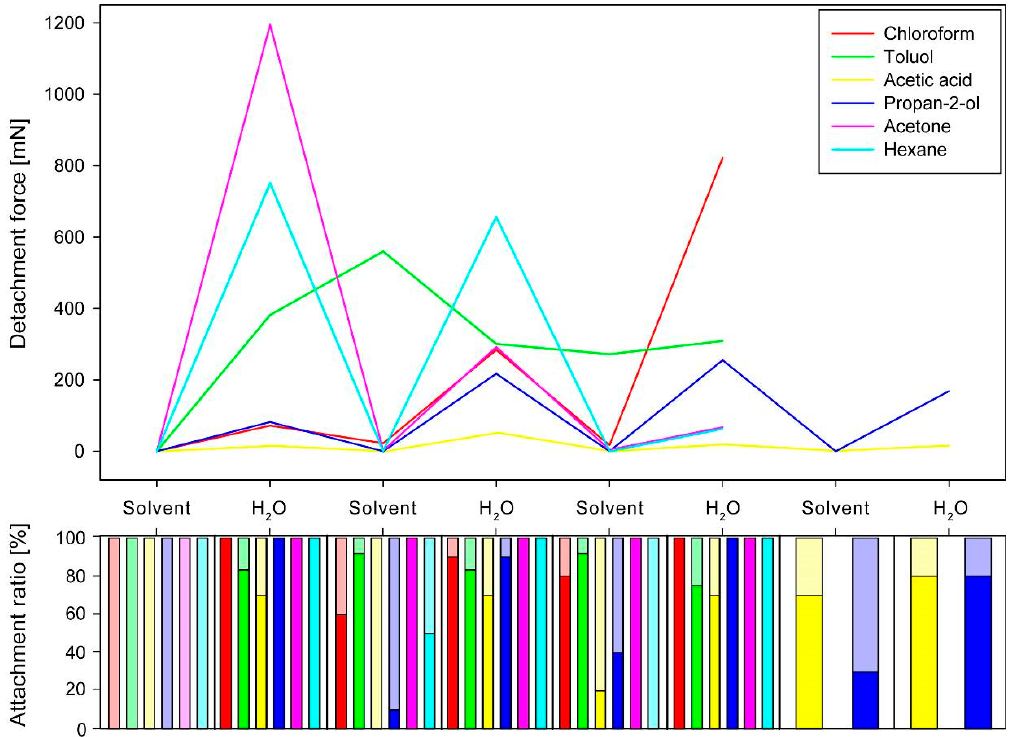
Figure 6. Sequential detachment force measurements of P. philippinicum eggs in sequential cross treatment experiments. Line plot (above) and the corresponding count of attached and detached eggs (attachment ratio, below) for sequential measurements of eggs alternatingly exposed to different solvents and water.